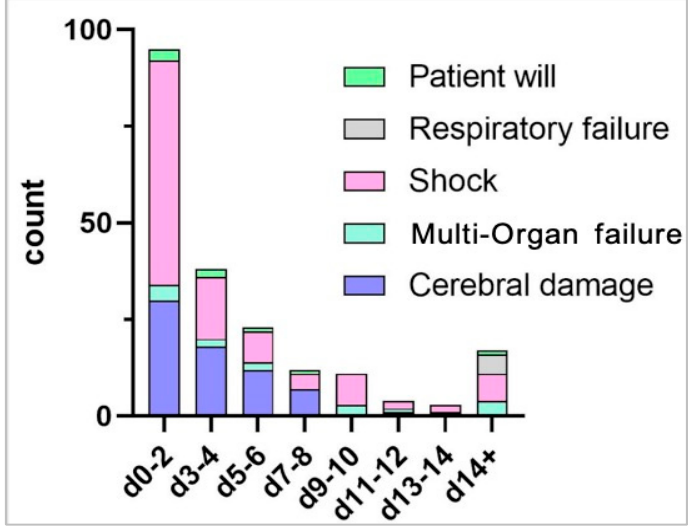
Figure 2. Timeline of Mode of Death after ECPR. A substantial number of patients died within the first two days after VA-ECMO cannulation. While death due to cerebral damage was prominent within the first week, shock was the major driver through the whole clinical course.